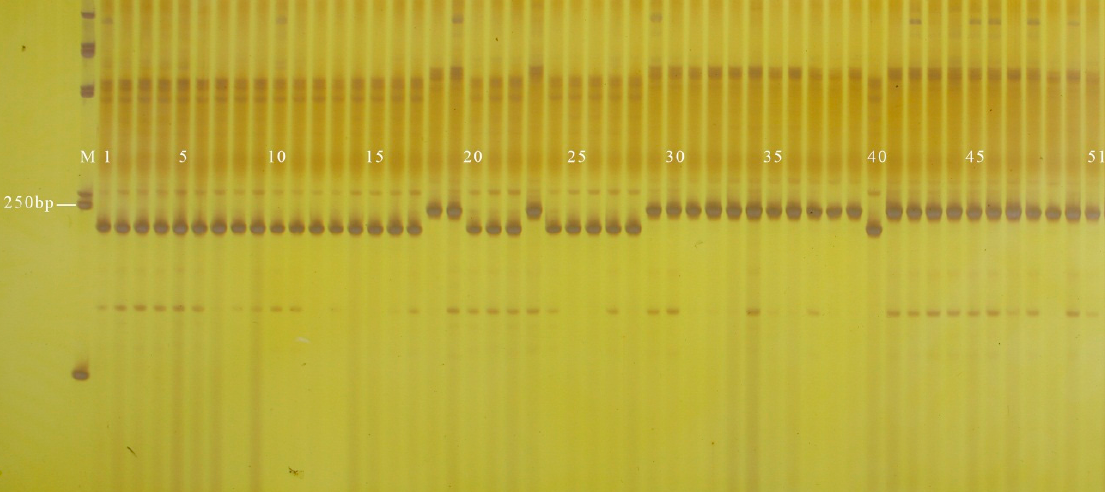
Figure 5. Amplification results of PS13 in some inbred line materials. M: DL2000 DNA. Marker; 1–